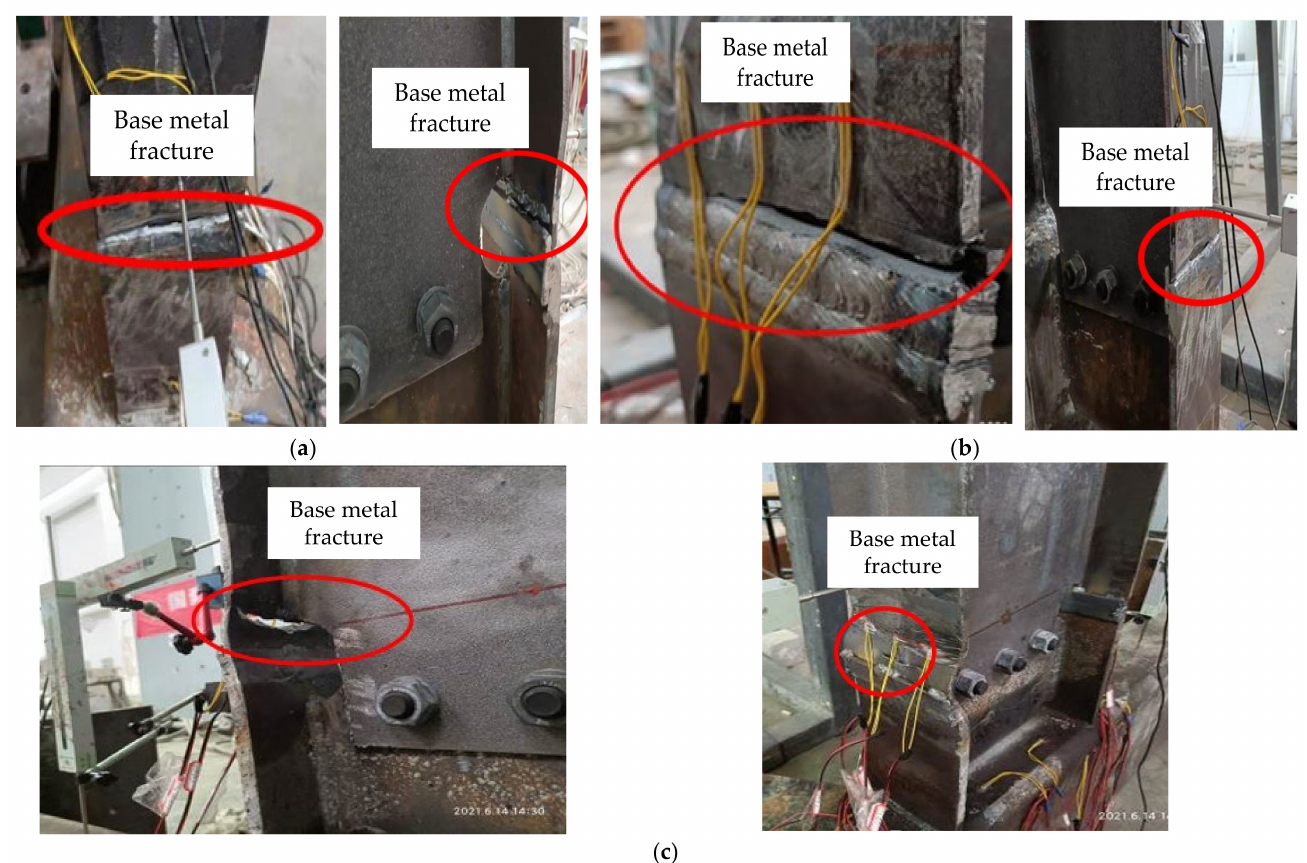
Figure 11. Failure modes of the test specimens: ( a ) Specimen S–CFT–A; ( b ) Specimen S–CFT–B; ( c ) Specimen